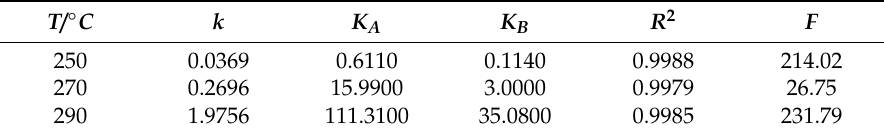
Table 3. UGO kinetic parameter fitting